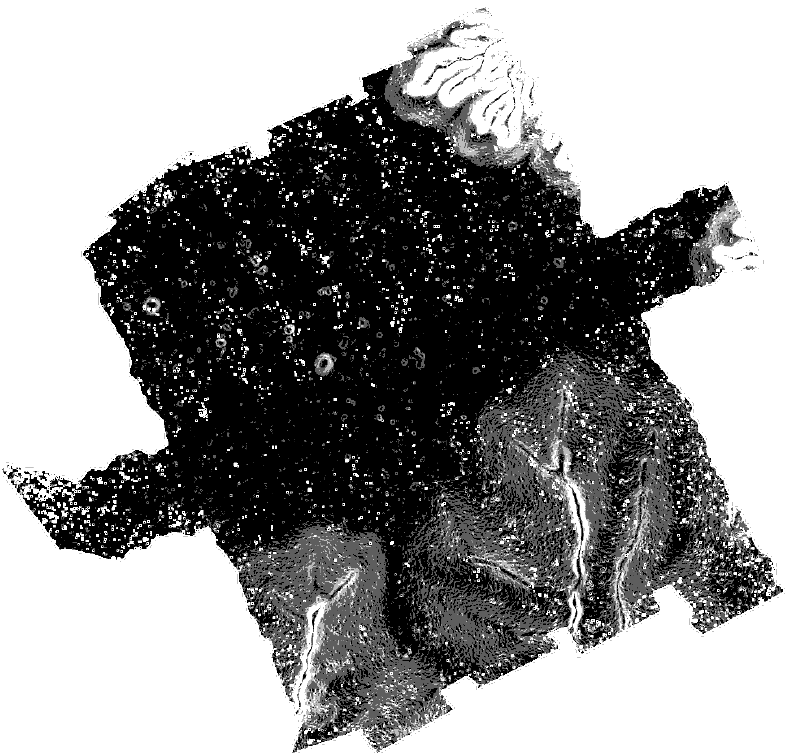
Figure 25. Flatness of the region crossed by the trajectory illustrated by the low magnitude of gradients. The greater the magnitude of the gradient are represented by whiter